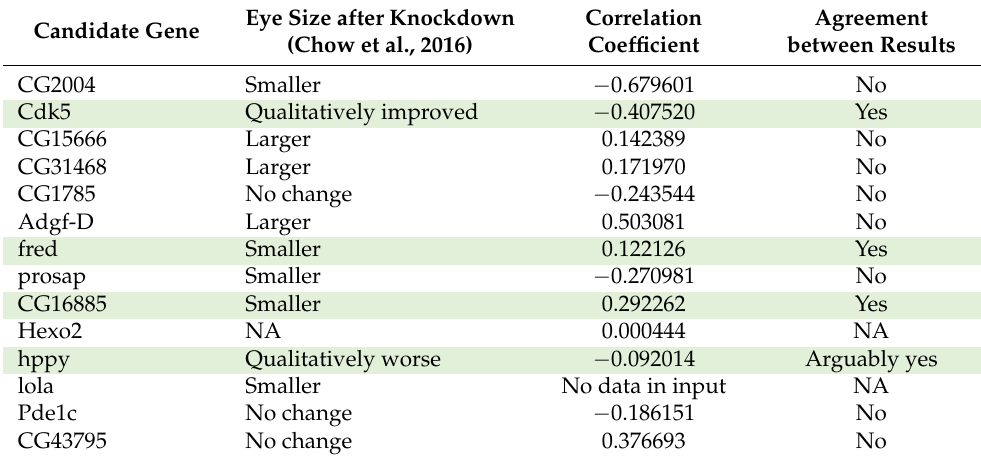
Table 4. Comparison with Chow’s study